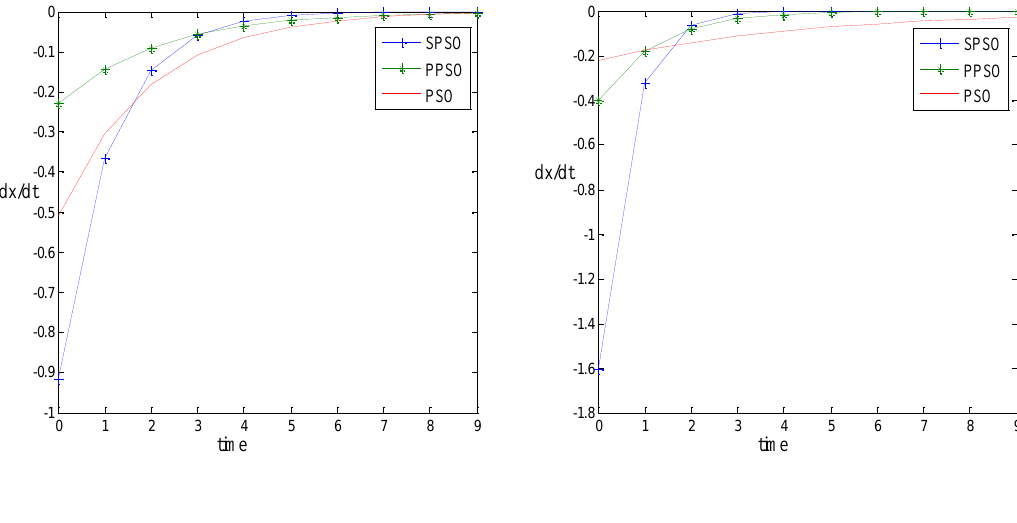
Figure 1. Variation of / dx dt with respect to time: (a) for ω = 0.6. (b) for ω = i